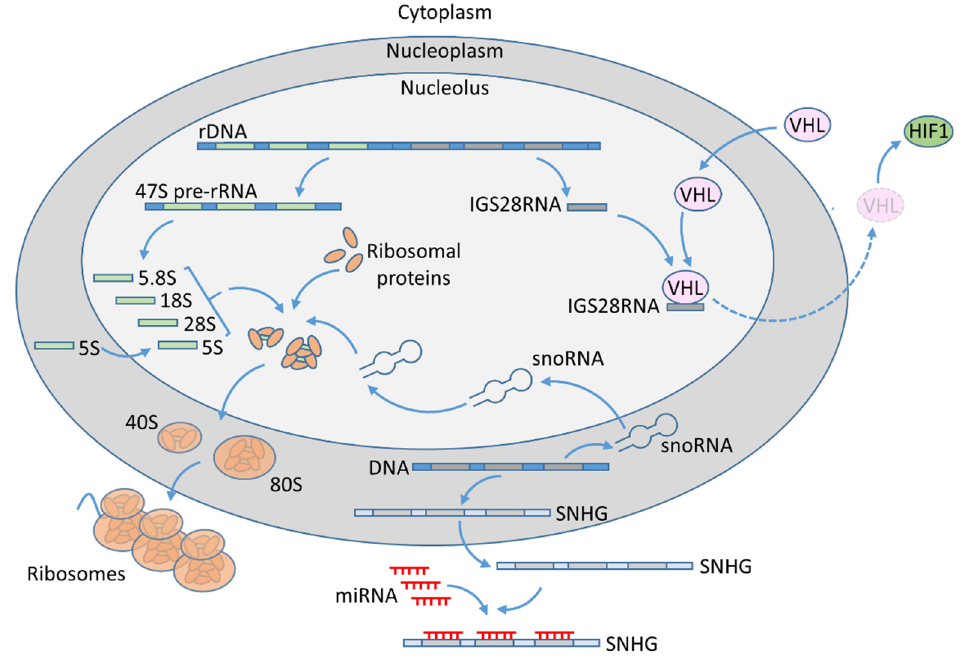
Figure 1. The role of nucleoli in ccRCC. Ribosome biogenesis: In the nucleolus, RNApol I generates 47S pre-rRNA, which is processed into 5.8S, 18S, and 28S rRNA. 5S rRNA is transcribed by RNApol III in the nucleoplasm and imported into nucleolus. The rRNA transcripts are processed and assembled together with ribosomal proteins, resulting in 40S and 60S ribosomal units. Ribosome maturation is assisted by snoRNAs, which are transcribed by RNApol II in the nucleoplasm from intronic sequences. SNHG transcripts are exported into cytoplasm where they can act as miRNA sponges, preventing their suppressive actions on target genes, including tumor-promoting MDM4, HIF1A, COL11A1, RUNX2, WNT2, and IGF1-R (see text for details). IGS28RNA is specifically expressed under acidic conditions in hypoxia. It binds and traps VHL tumor suppressor in the nucleolus, preventing its actions in the cytoplasm. As a result, VHL-mediated ubiquitination and proteasomal degradation of HIF1 are attenuated, leading to its stabilization.